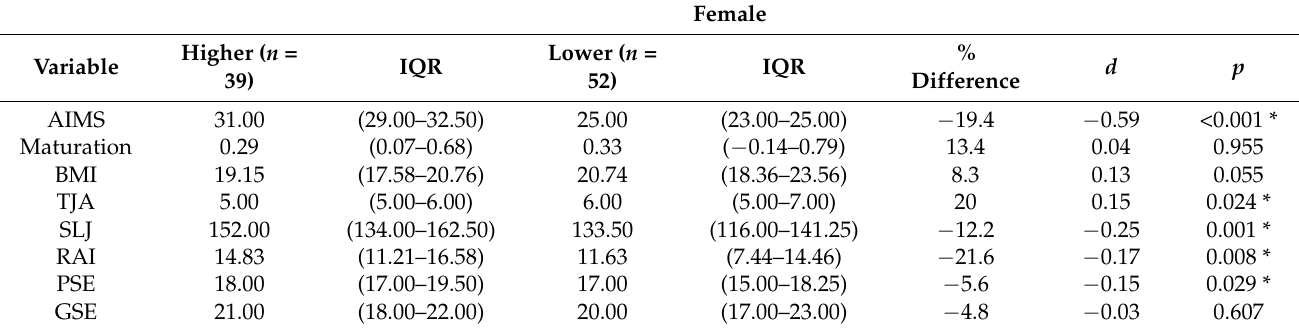
Table 7. Differences in characteristics between groups based on AIMS score in